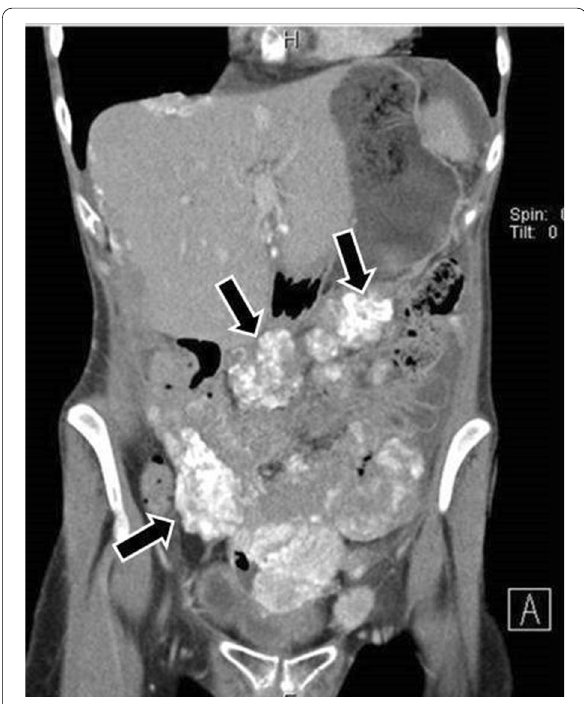
Fig. 2 Patient with ovarian cancer and peritoneal carcinomatosis. Coronal reconstructed CT image shows multiple voluminous calcified implants in the peritoneum (black arrows)